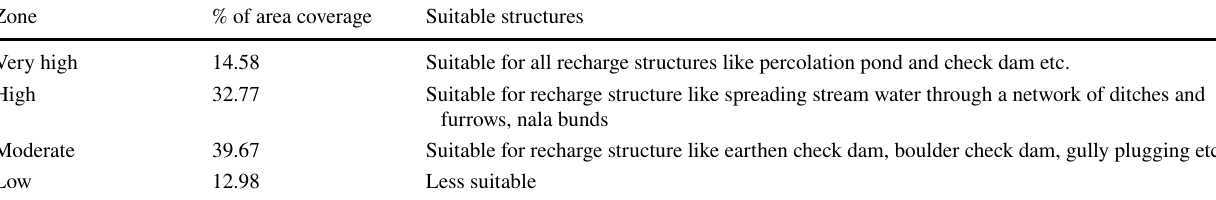
Table 8 Resultant output showing percentage of zone wise area of coverage